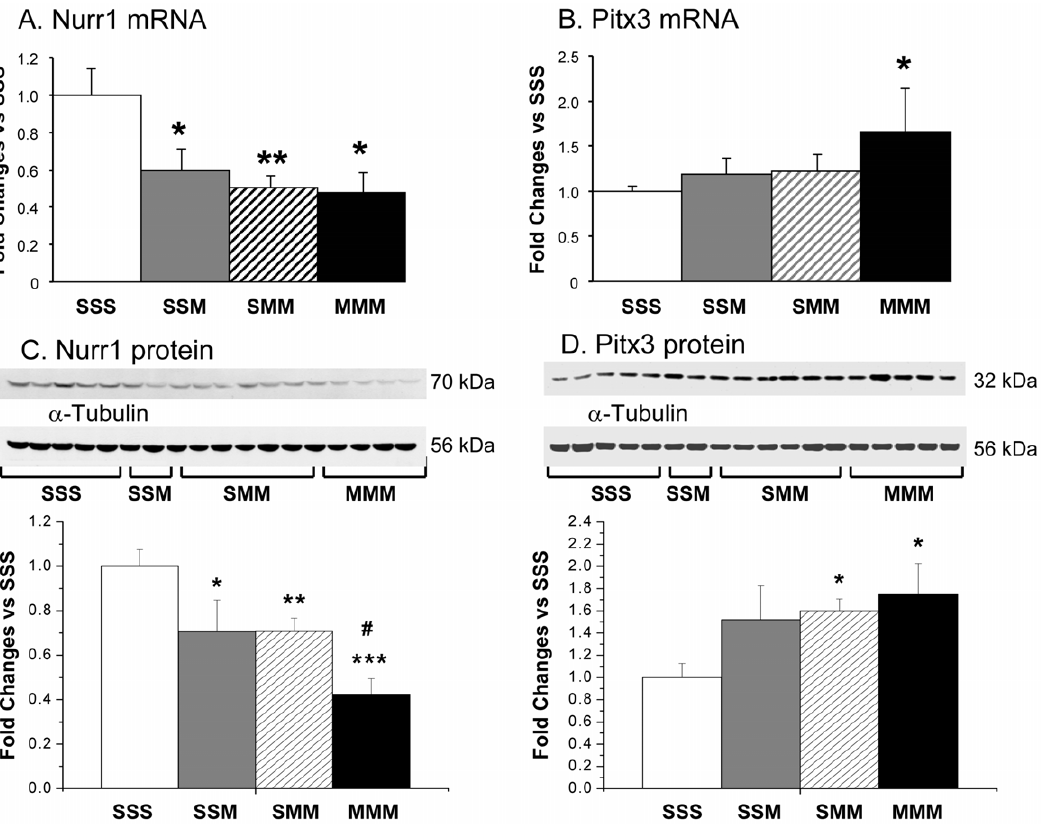
Figure 7. METH caused differential changes in Nurr1 and Pitx3 mRNA and protein levels in the midbrain. METH injections resulted in significant decreases in Nurr1 expression in all the groups (A). In contrast, METH challenges caused significant increases in Pitx3 mRNA expression only in the METH-preconditioned rats (B). Consistent with the mRNA data, toxic METH challenges caused decreases in Nurr1 protein levels in all the groups (C). In contrast, Pitx3 protein levels were increased by METH (D). The values represent means 6 SEM in comparison to the saline-pretreated challenged with saline group (SSS). N=3–6 animals per group. Keys to statistics are as described in the legend to Fig. 4.